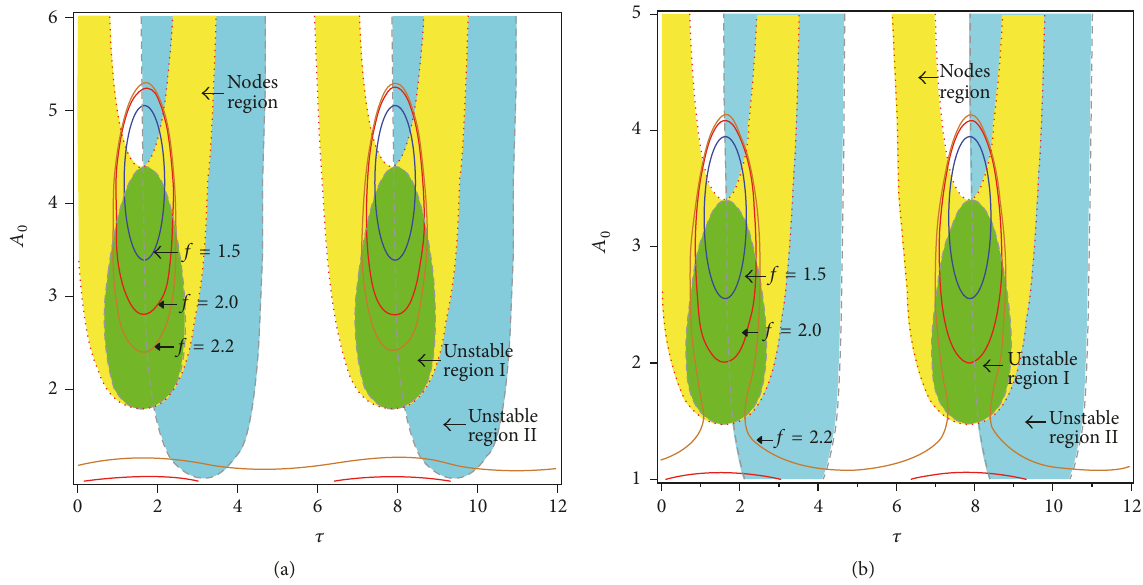
Figure 6: Effect of time delays on vibration amplitudes with different feedback gains. Solid lines: response curves (a) 𝑏 = 0.05 ; (b) 𝑏 = 0.1 .